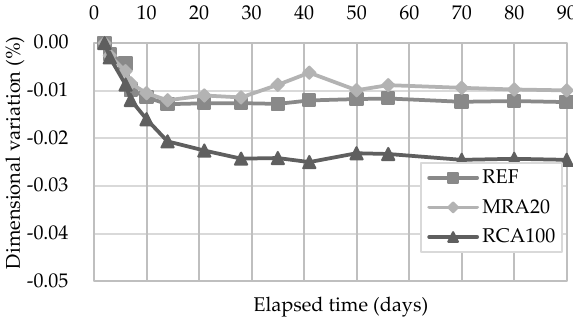
Figure 13. Dimensional variation of the mortars tested.